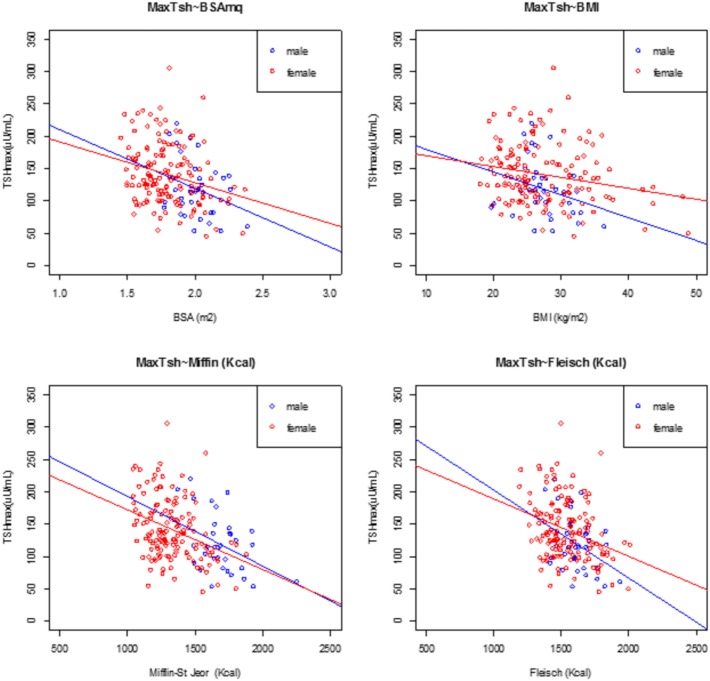
Linear regression analysis at peak TSH and body surface area (BSA), body mass index (BMI), Mifflin-St Jeor equation, and Fleisch equation at day 3, divided by male (filled circle blue) and female (open circle red).